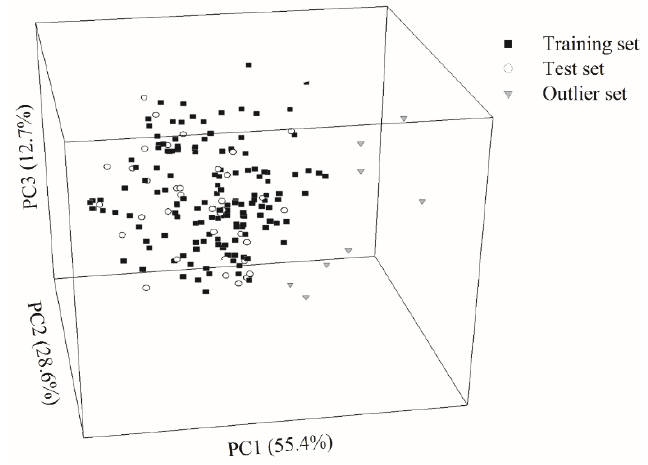
Figure 2. Molecule distribution for the molecules selected for this study in the training set (solid square), test set (open circle), and outlier set (grey triangle) in the chemical space spanned by three principal components.